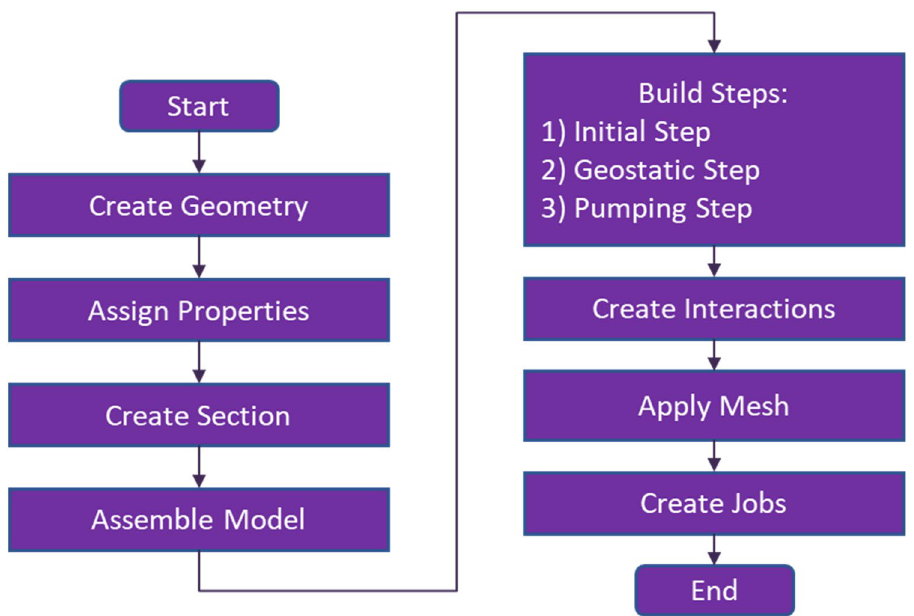
Fig. 6 General steps in XFEM